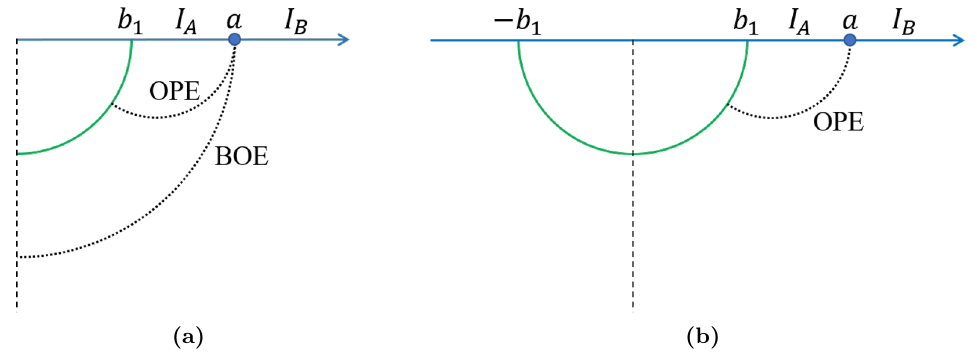
Figure 6. (a) Holographic illustration of possible channels. The brane BCFT has a holographic bulk dual cut off by an End-of-the-World brane represented by the dashed vertical line. The RT surface for I A ∪ I B is represented by the green arc. The correlators in (4.6) have two possible channels, which correspond to the area of two different wedge cross sections separating I A and I B represented by dashed arcs. From the field theory side, the BOE channel corresponds to a product of two one-point BCFT correlators. (b) The OPE channel of the two-point BCFT correlator is equivalent to a three-point function on a whole